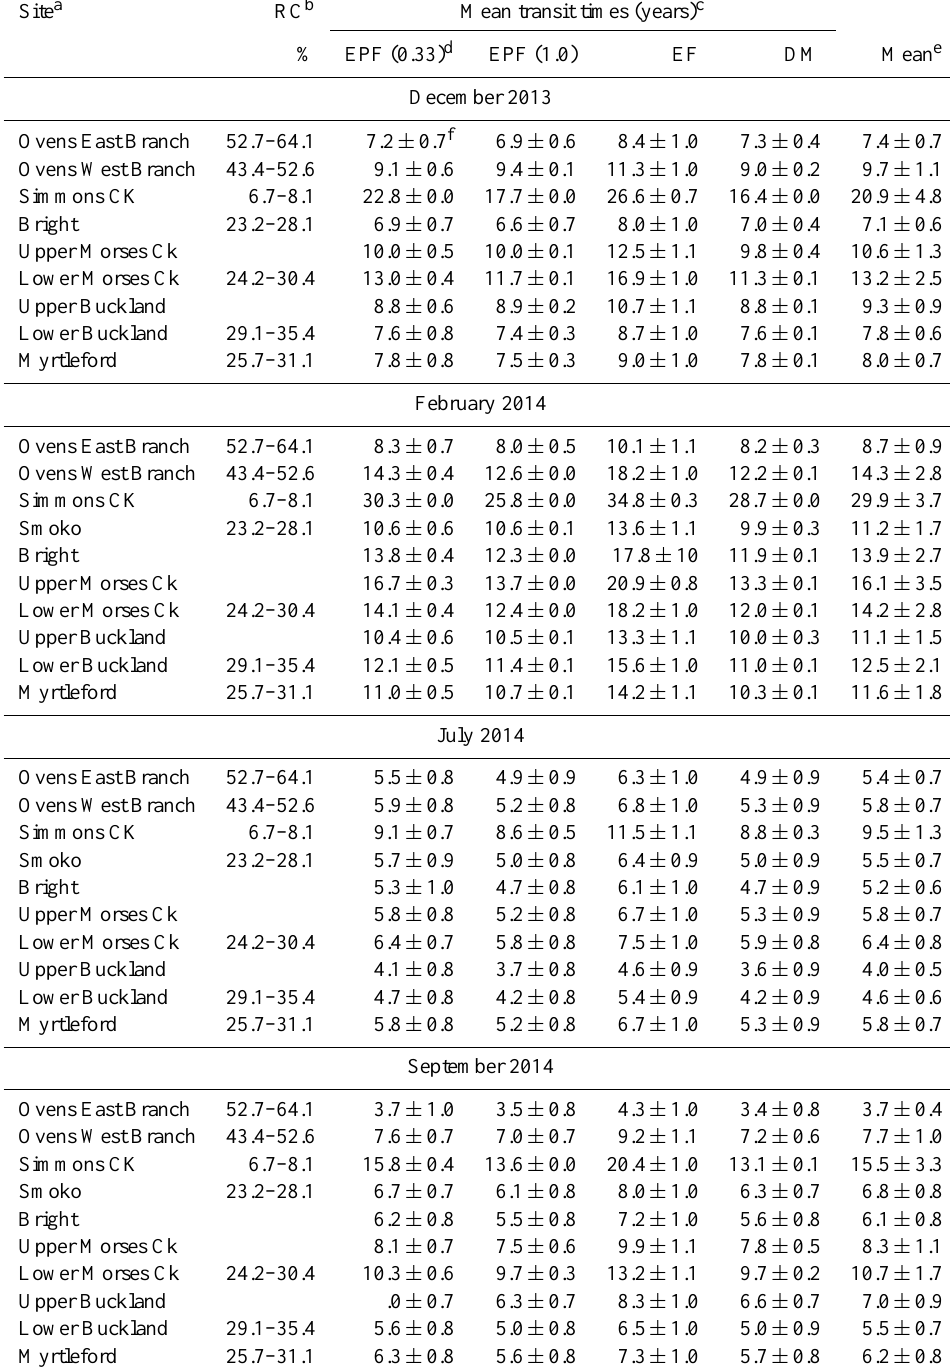
a Sites on Fig. 1. b Runoff coefficient, range reflects likely rainfall range in catchments. c Lumped parameter models: EF = exponential flow, DM = dispersion model, EPF = Exponential–Piston flow with EPM ratios of 0.33 and 1.0. d Model discussed in text. e Mean and standard deviation of mean transit time from the four models. f Uncertainty calculated from different values of modern rainfall input as discussed in